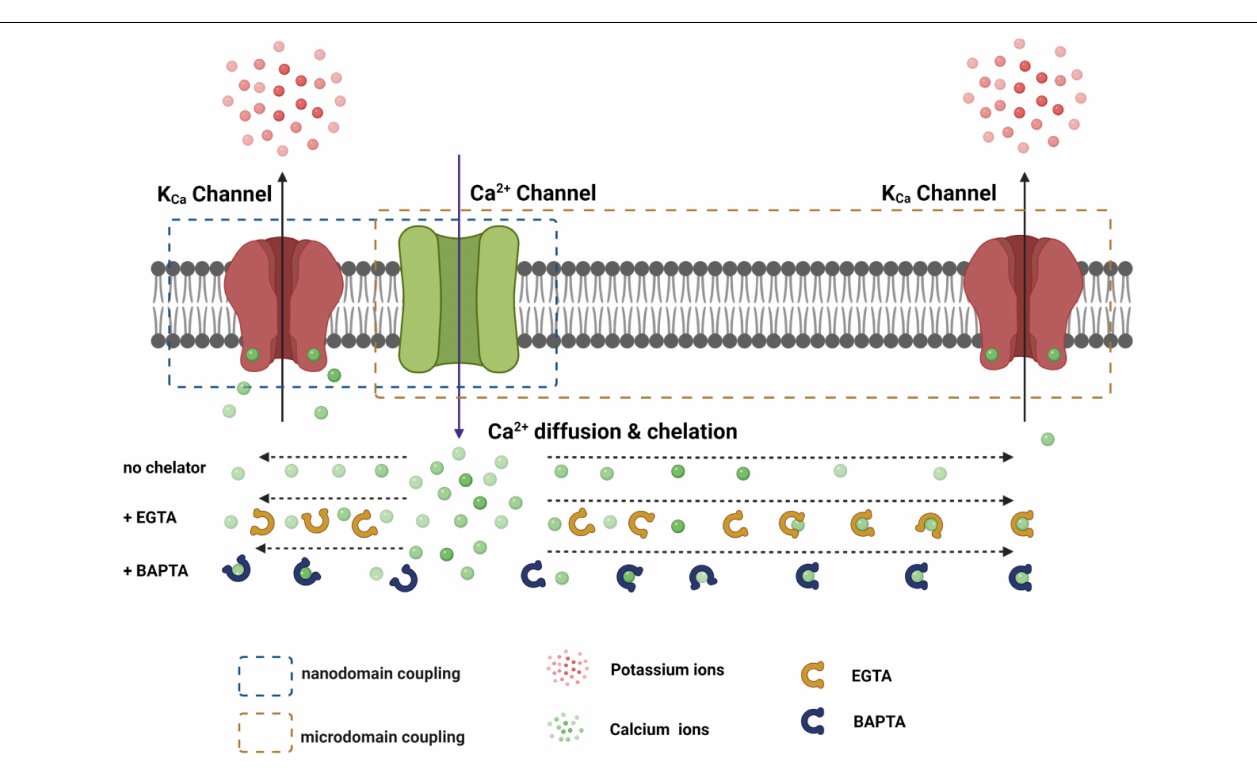
FIGURE 3 | Functional coupling of the K Ca channel with the Ca 2 + channel within nanodomain and microdomain. The distance-dependent effects of EGTA and BATPA on the availability of free Ca 2 + ions during their diffusion from the Ca 2 + channel pore are roughly